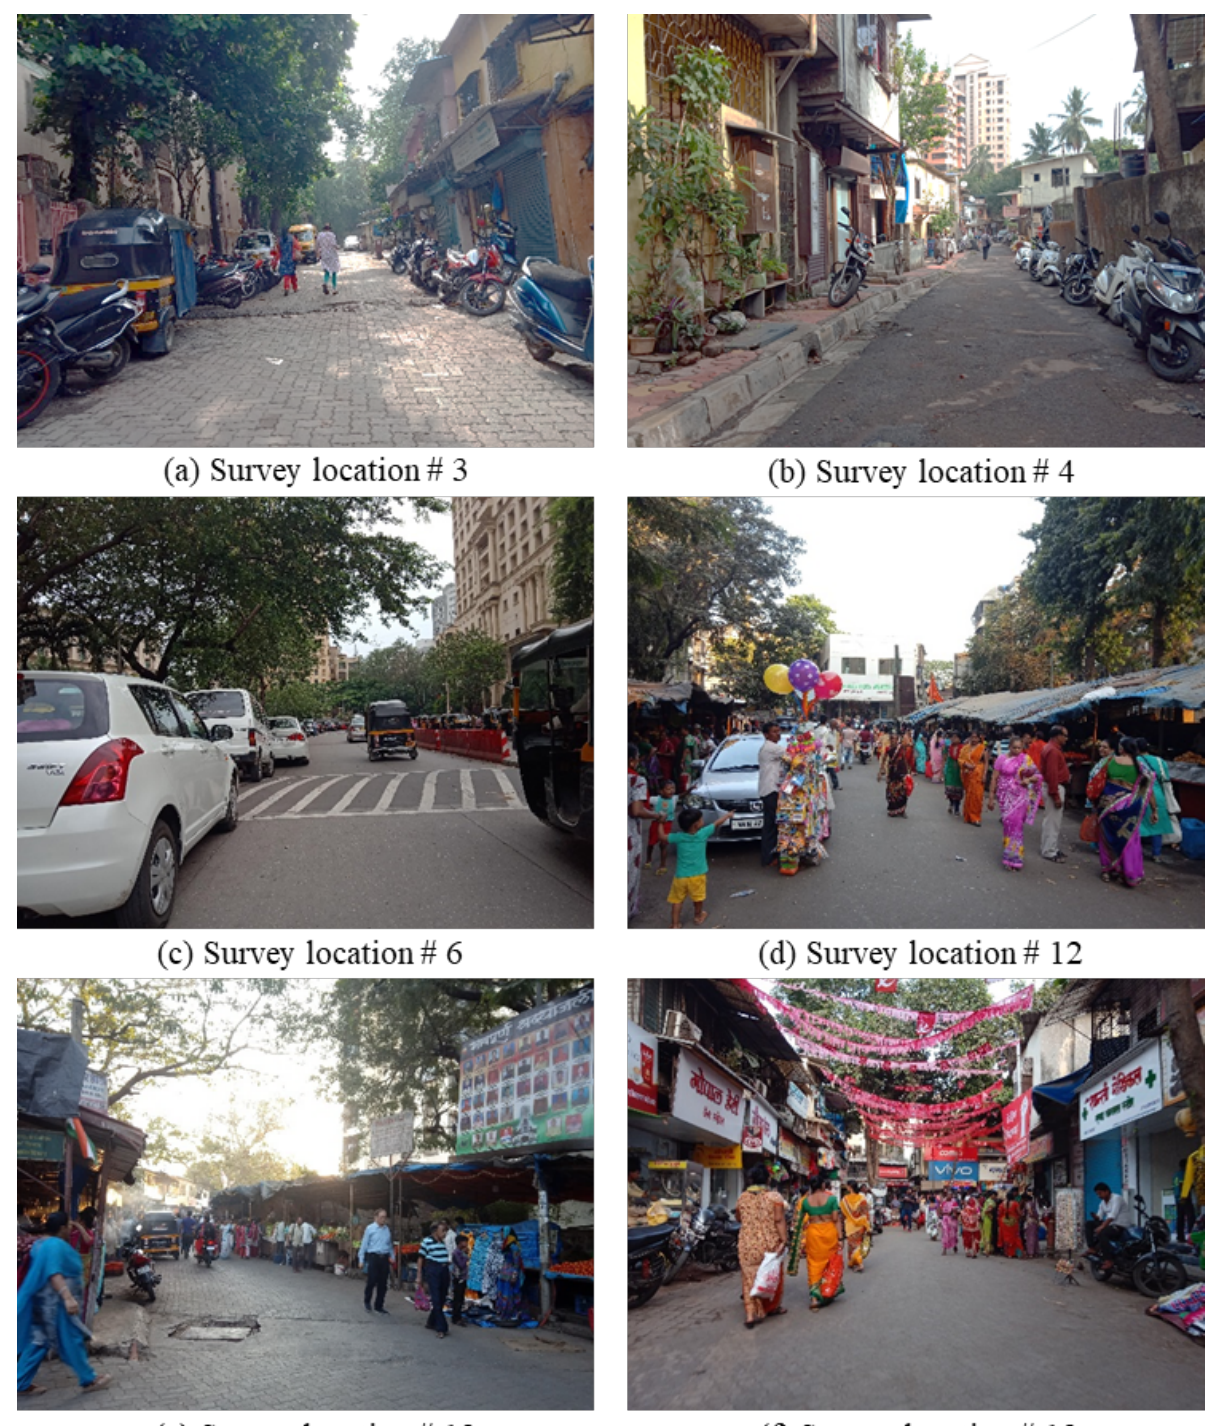
Figure 4: Photographs taken at some of the survey